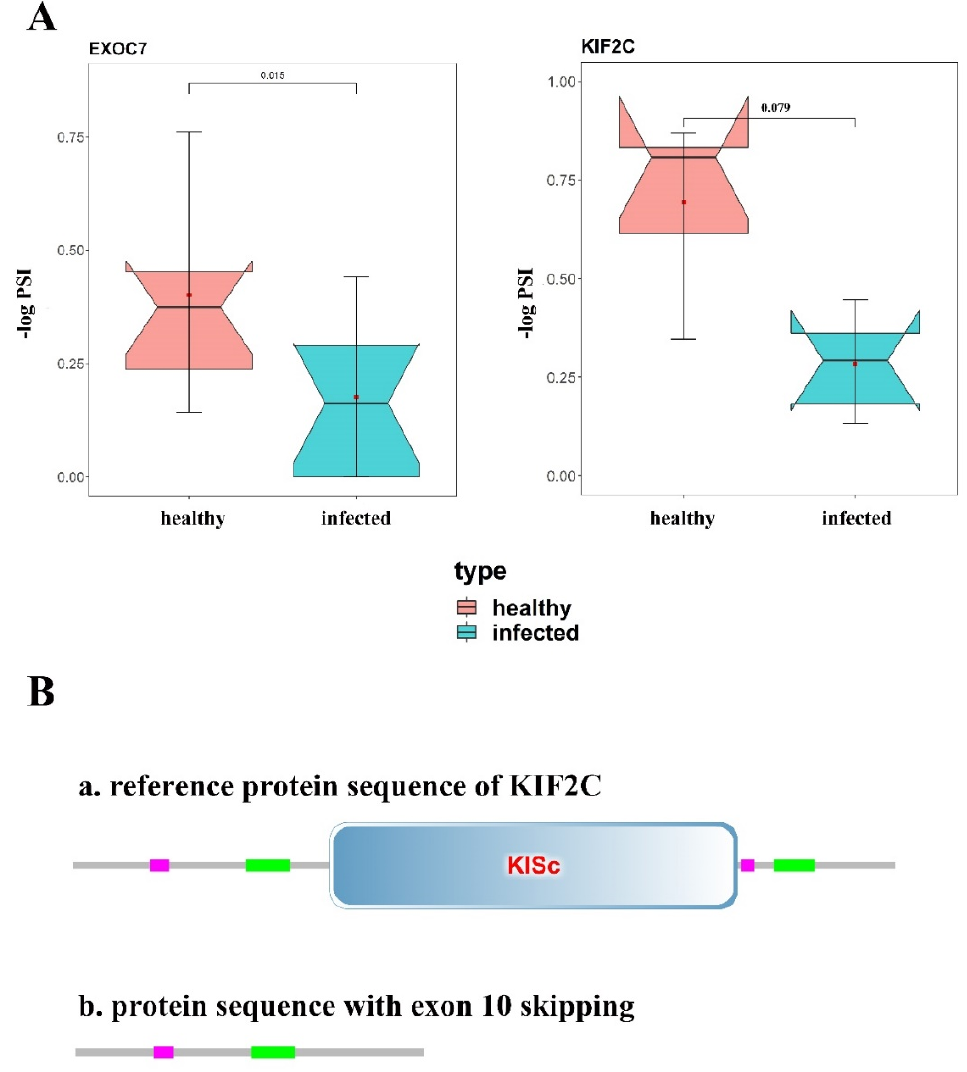
Figure 4. KS − test of candidate DAS events and protein structure prediction of corresponding genes. ( A ) KS test of DAS events in EXOC7 and KIF2C. Dots in red part mean PSI values of DAS event in healthy cows, and blue part mean that in infected cows. ( B ) Protein structure of KIF2C before and after exon 10 skipping. Skipped exon 10 cause the lack of KISc domain of KIF2C.